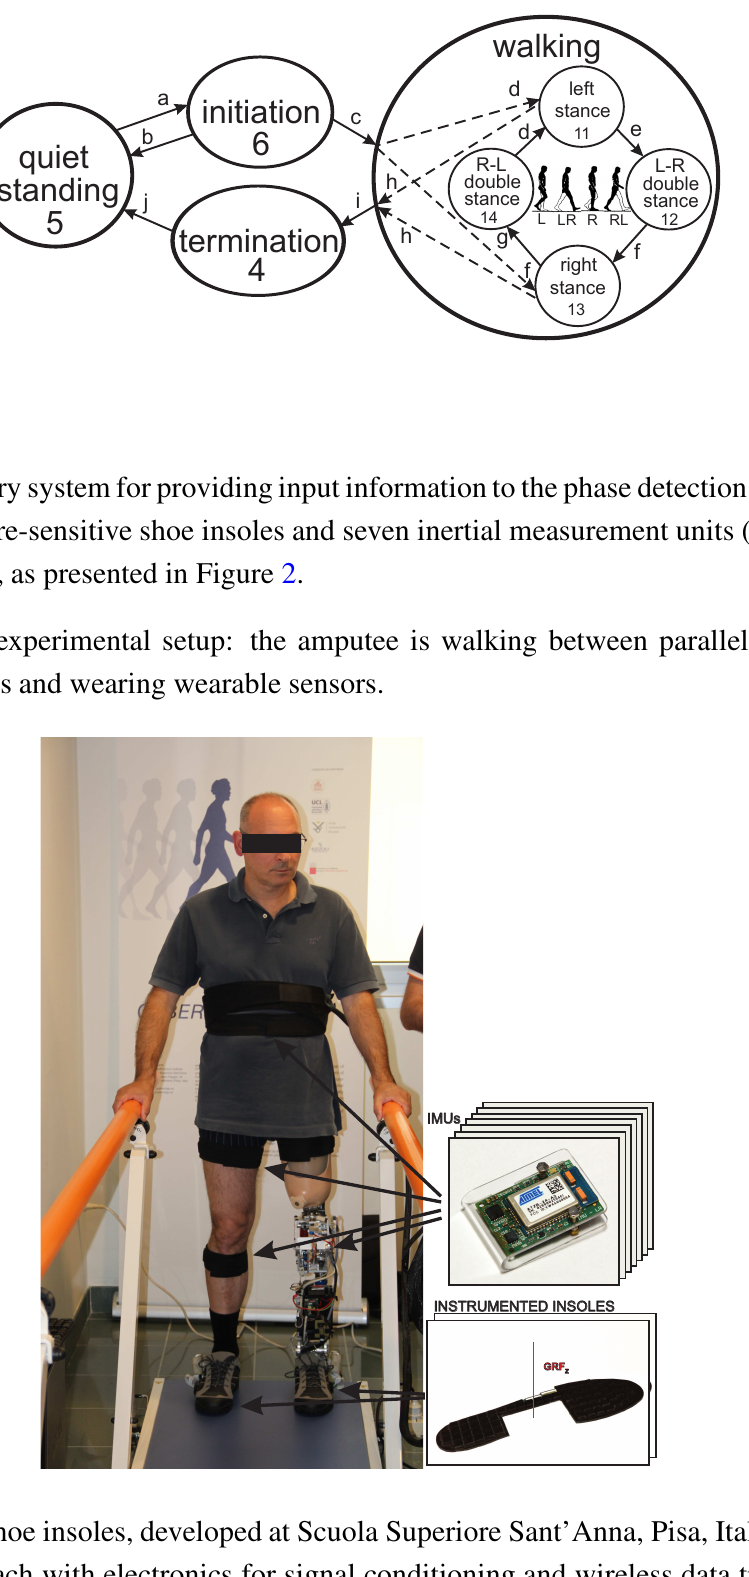
Figure 1. The state diagram of the intention detection algorithm and prosthetic control.